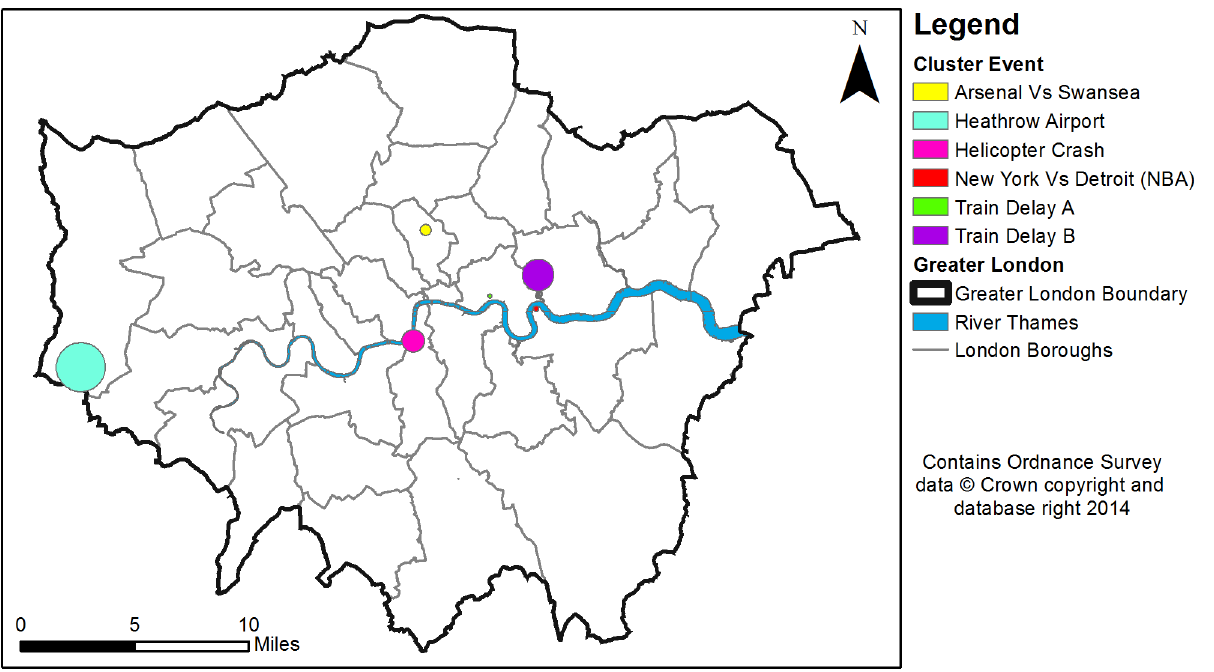
Figure 8. A top view of hourly cluster events identified within London between 16th January and 17th January 2013.